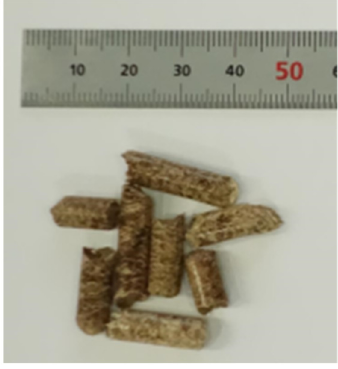
Figure 3. Pellet photo.